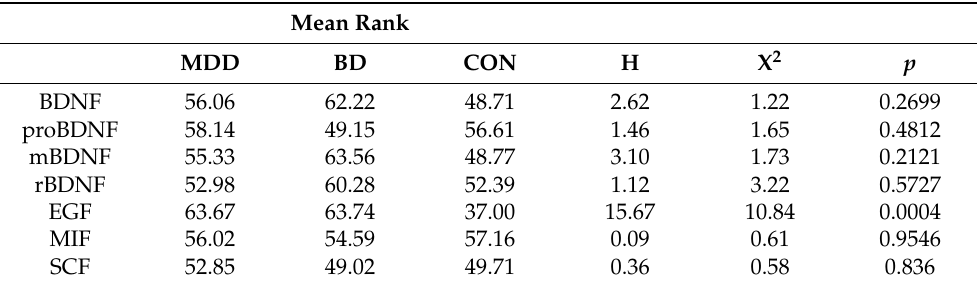
Figure 1. Baseline comparison of epidermal growth factor (EGF) serum levels between major depressive disorder (MDD), bipolar (BD) and controls (CON). BD vs. CON p = 0.001; MDD vs. CON p = 0.0002. *MDD—Major Depressive Disorder; BD—Bipolar Disorder; CON—Healthy Controls. Table 2. Baseline comparisons of protein levels between major depressive disorder (MDD), bipolar disorder (BD) and healthy controls (CON).